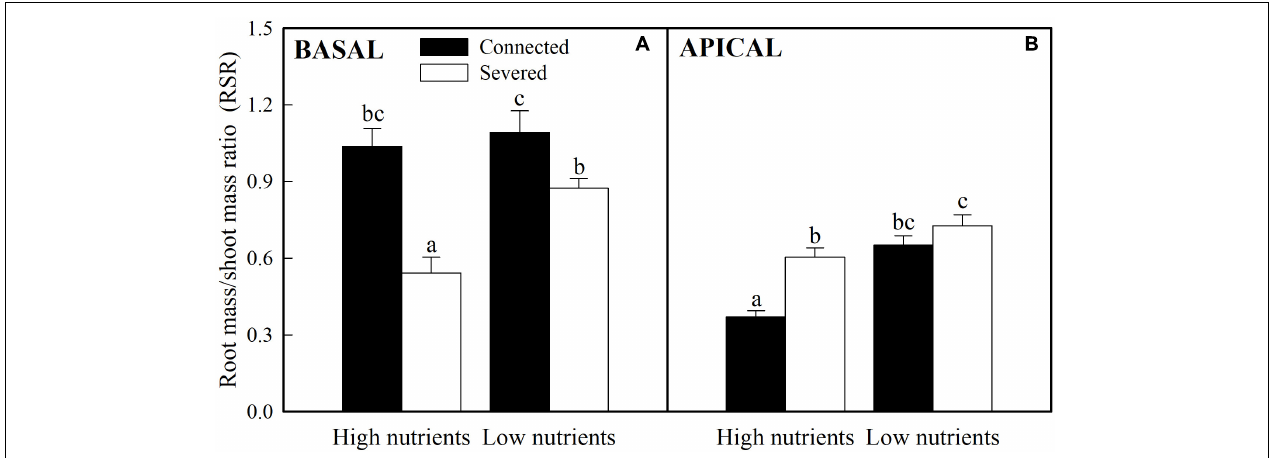
FIGURE 2 | Effects of experimental treatments on the root to shoot mass ratio of basal (A) and apical (B) ramets of A. philoxeroide . The data indicate the means + SE ( n = 8). The bars sharing the same letter are not significantly different at P = 0.05.